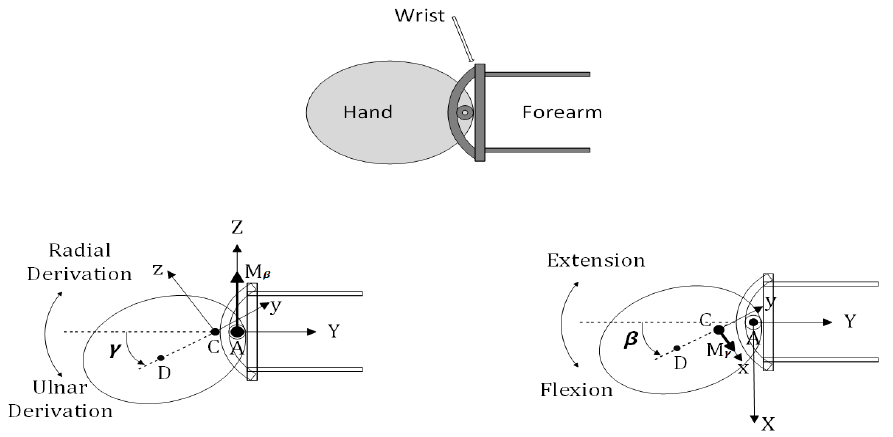
Figure 4. Diagram of the actual wrist and universal joint model.